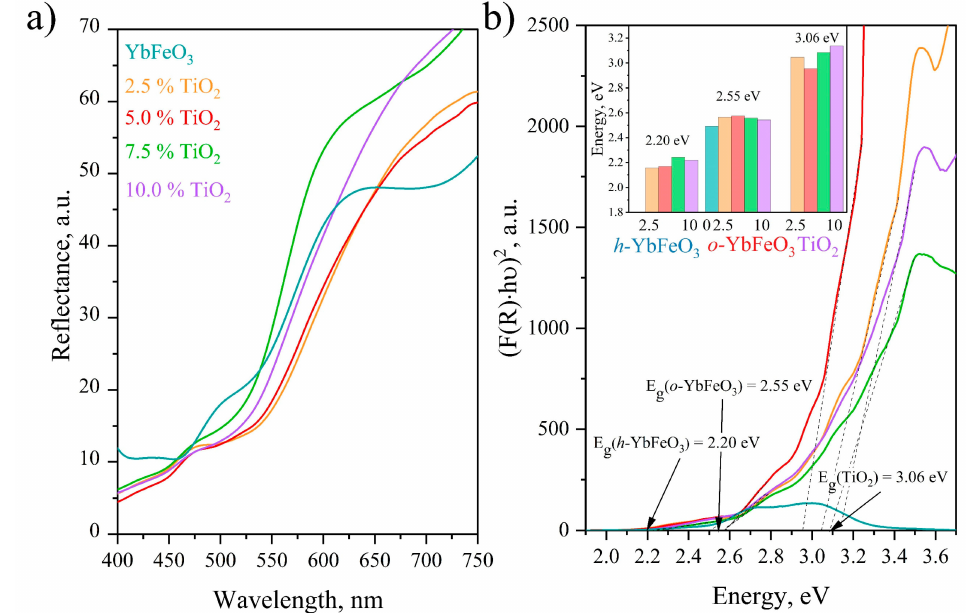
Figure 7. Diffuse reflectance spectra ( a ), Tauc plots ( b ), and band gap energy values (inset in b) of the o -YbFeO 3 / h -YbFeO 3 /TiO 2